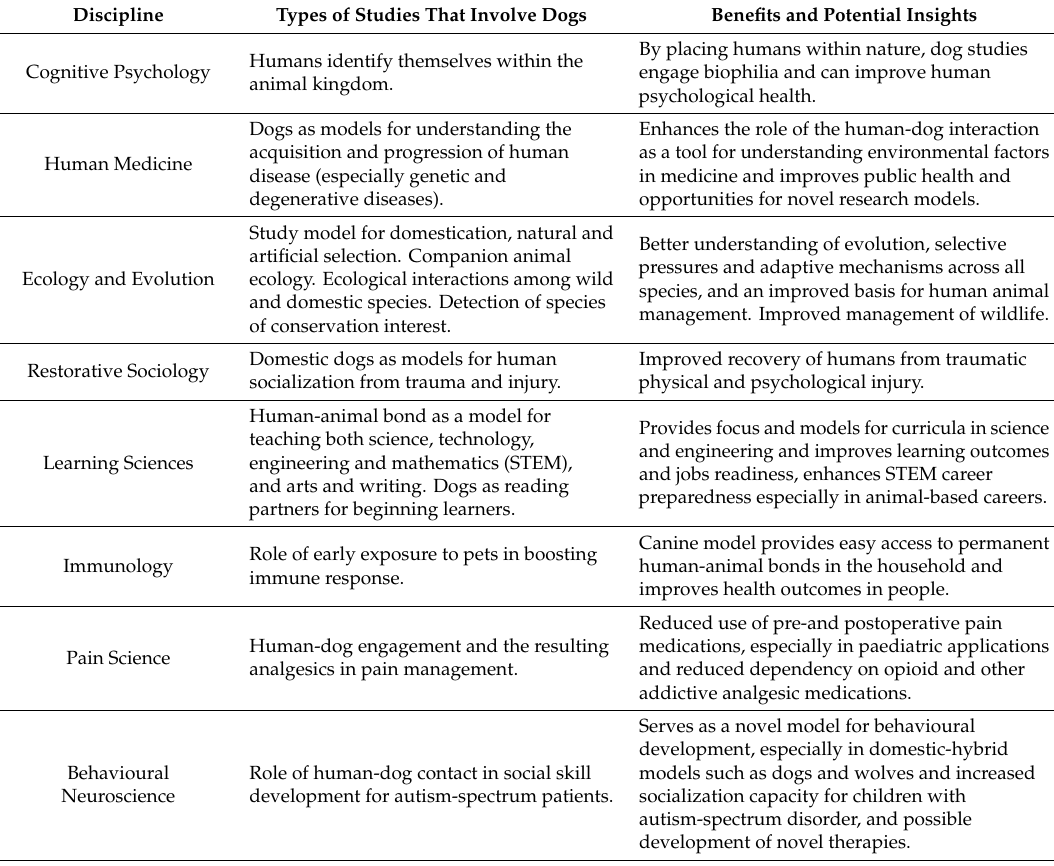
Table 1. The potential and realized benefits of dog-focussed studies across multiple disciplines. Discipline Types of Studies That Involve Dogs Benefits and Potential Insights Humans identify themselves within the Cognitive Psychology animal